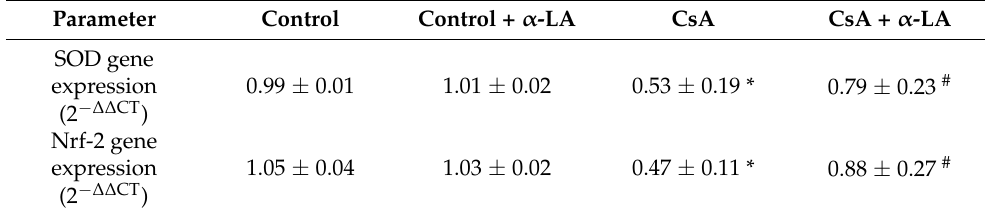
Figure 2. Microscopic pictures of the Sirius red-stained hepatic sections. The control normal group ( A – C ) shows no fibrous tissue deposition around central veins (CV) or portal areas (P). Hepatic sections ( D , E ) from the CsA-treated group show excessive red-stained fibrous connective tissue deposition (arrows). Hepatic sections ( F , G ) from the (CsA + LA) treated group show thin red-stained fibrous connective tissue deposition (arrows), ( A , D , F ; Scale bar = 100 μ m), and ( B , C , E , G ; Scale bar = 50 µ m). ( H ) represents a quantitative analysis of liver fibrosis determined by the % collagen deposition calculation from the Sirius red stain. Data are displayed as mean ± SE. *** p < 0.001 vs. control group and ### p < 0.001 vs. CsA-treated group. Table 4. Effect of α -LA administration on hepatic tissue mRNA expression of SOD and Nrf-2 genes in CsA-treated